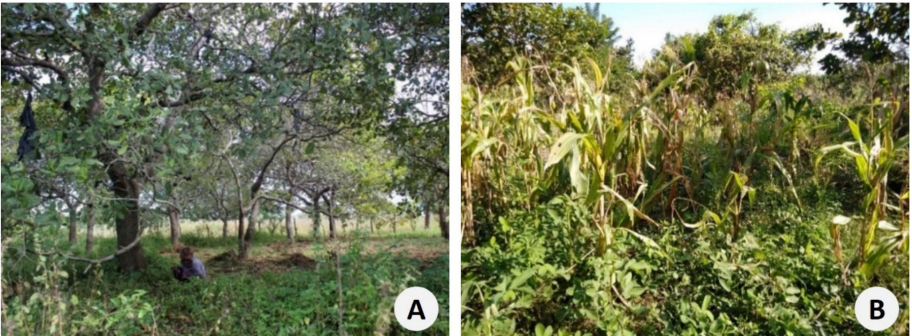
Figure 3. Cashew agroforestry systems in East Timor: ( A ) in Maliana (Maumali): cashew and Crotaria